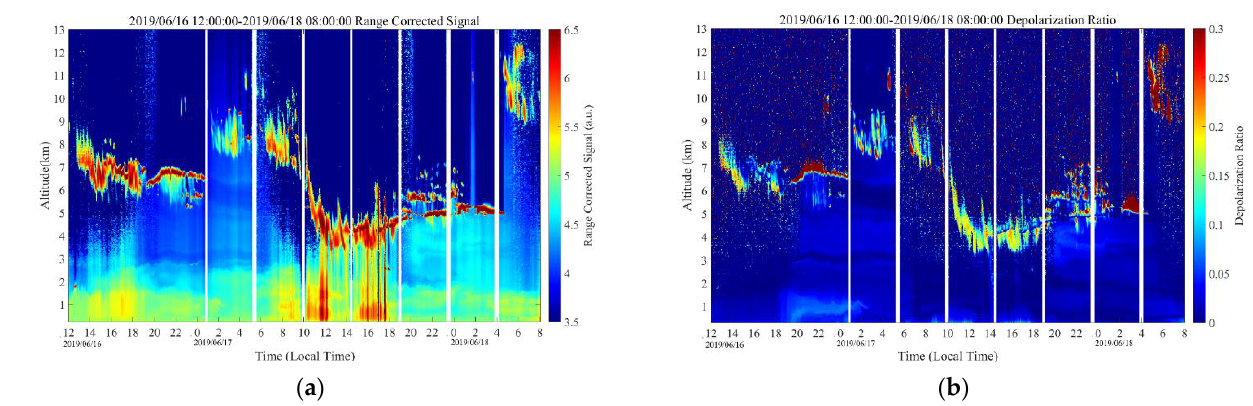
Figure 8. ( a )THI of RCS and ( b ) THI of DR from 12:00 on 16 June to 8:00 on 18 June 2019. In Figure 9, the profiles of temperature, PT, and RH of the GTS1 Digital Radiosonde data and the extinction coefficient profiles retrieved from the P-MPL data at different times are shown. By combining the data of the GTS1 Digital Radiosonde and the lidar, the aerosols and clouds are further analyzed.